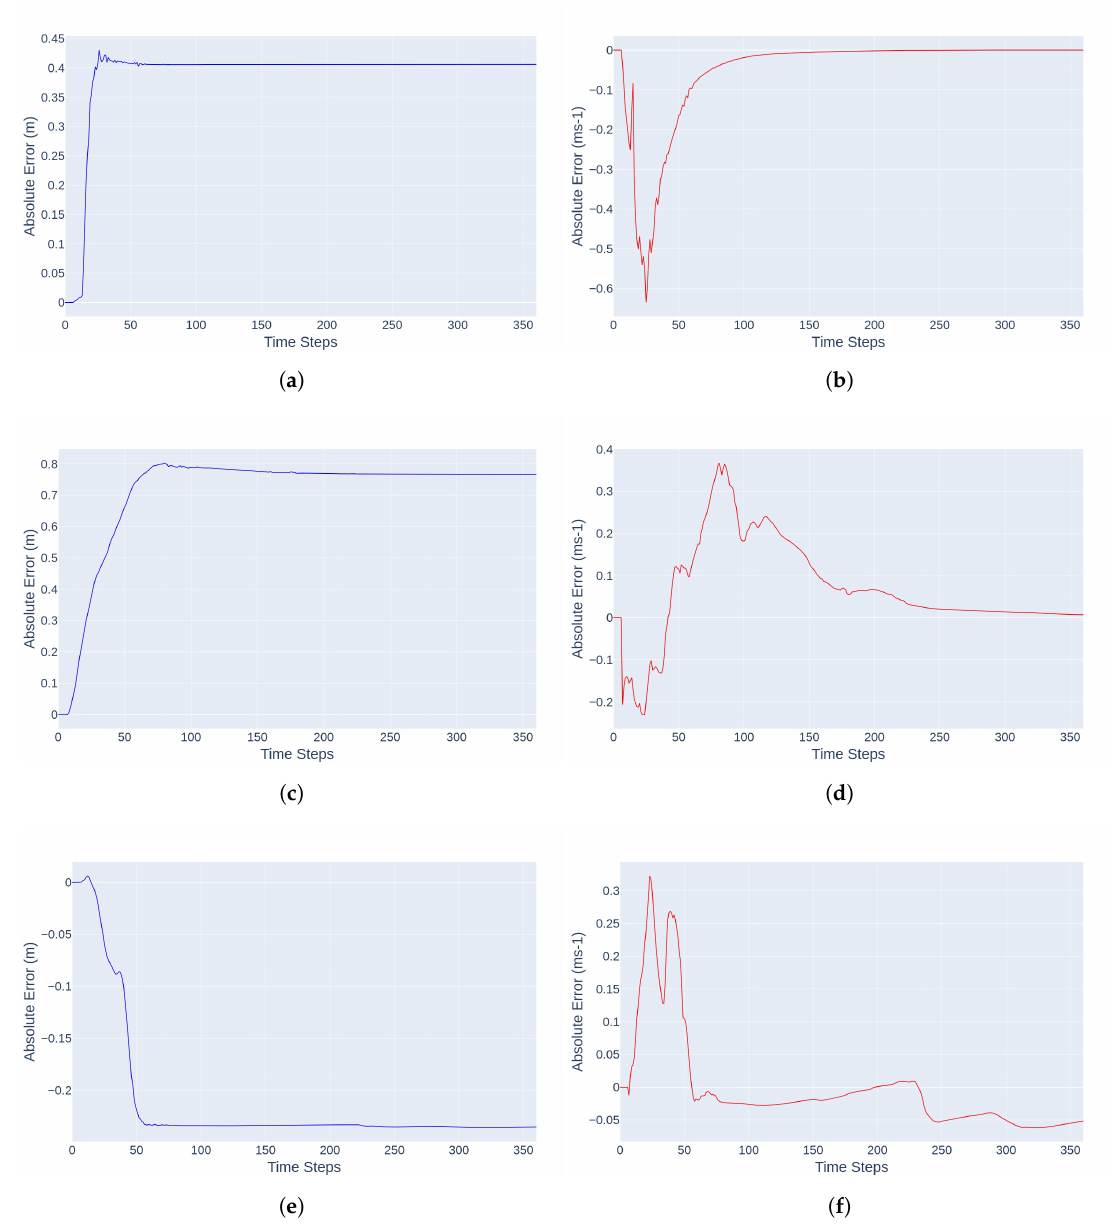
Figure 9. Residual plots (ANUGA-CAMC) for water depth ( left ) and velocity ( right ): ( a , c , e ) Water depth at gauges 1–3; ( b , d , f ) Velocity at gauges